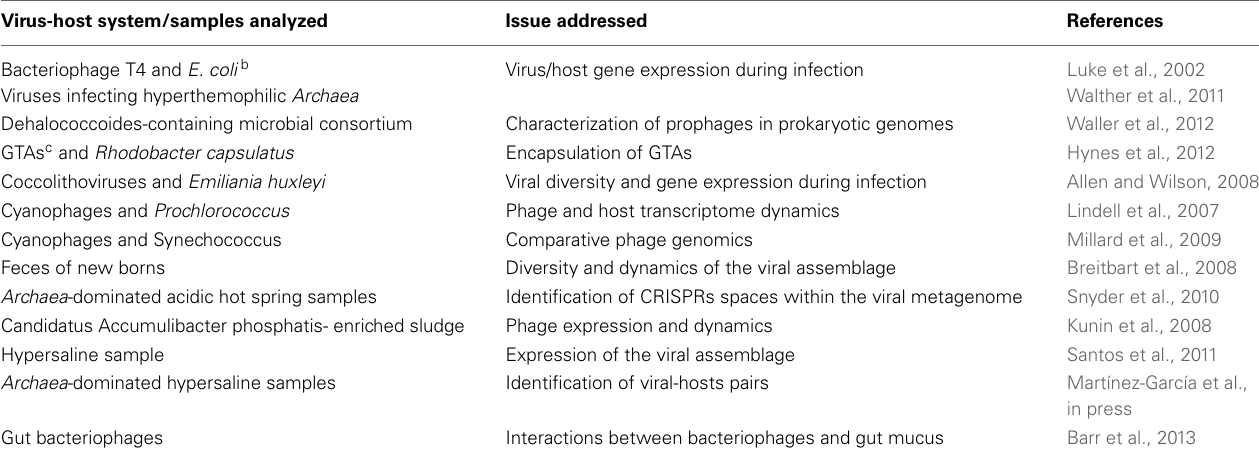
Table 1 | Some examples of the use of microarrays to study microbial viral ecology a . Virus-host system/samples